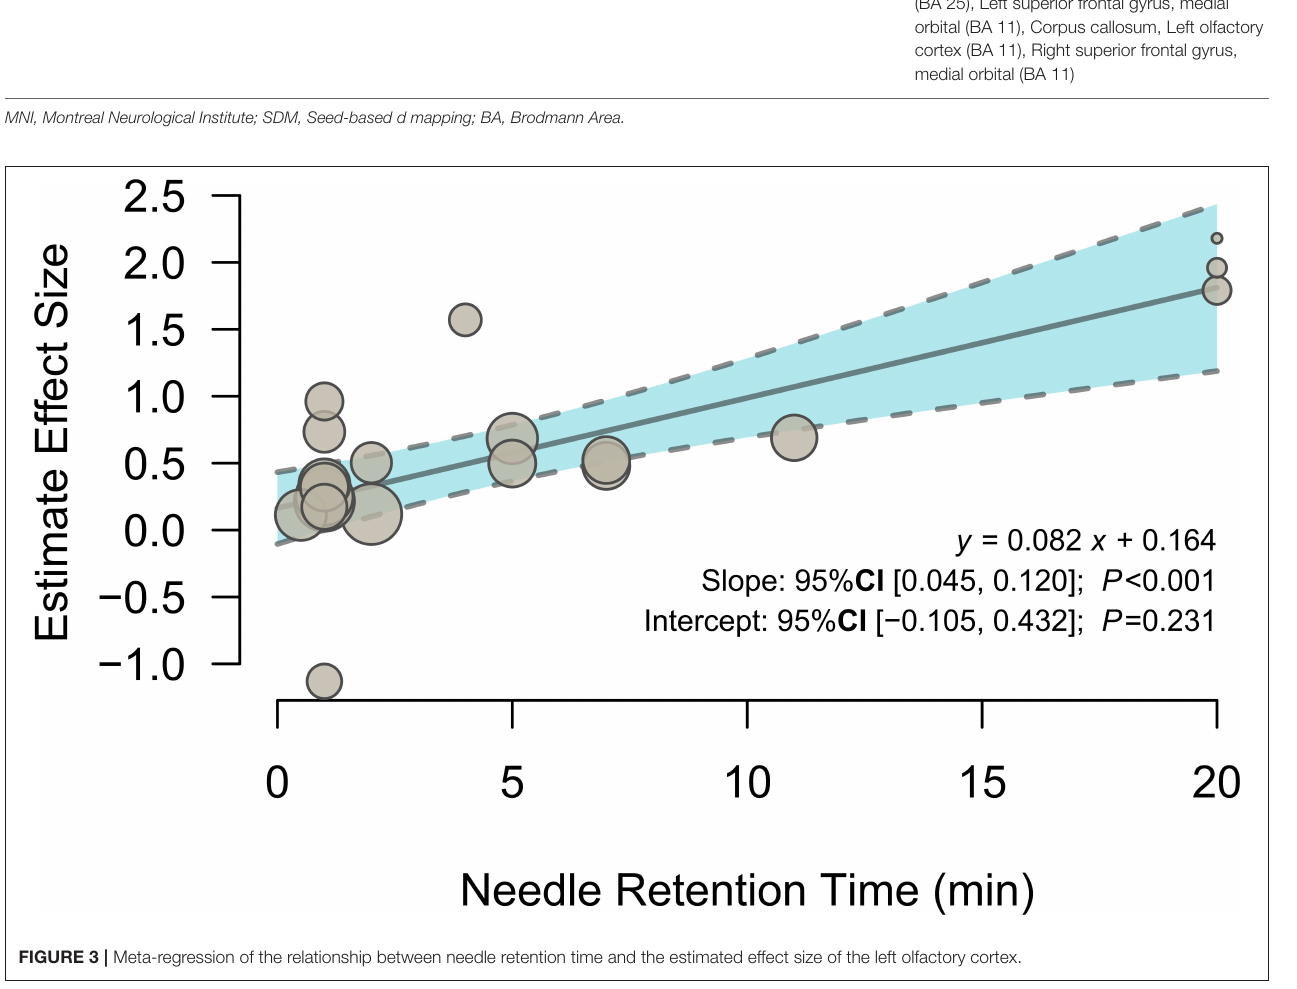
( Supplementary Table S5 ), such as the left superior